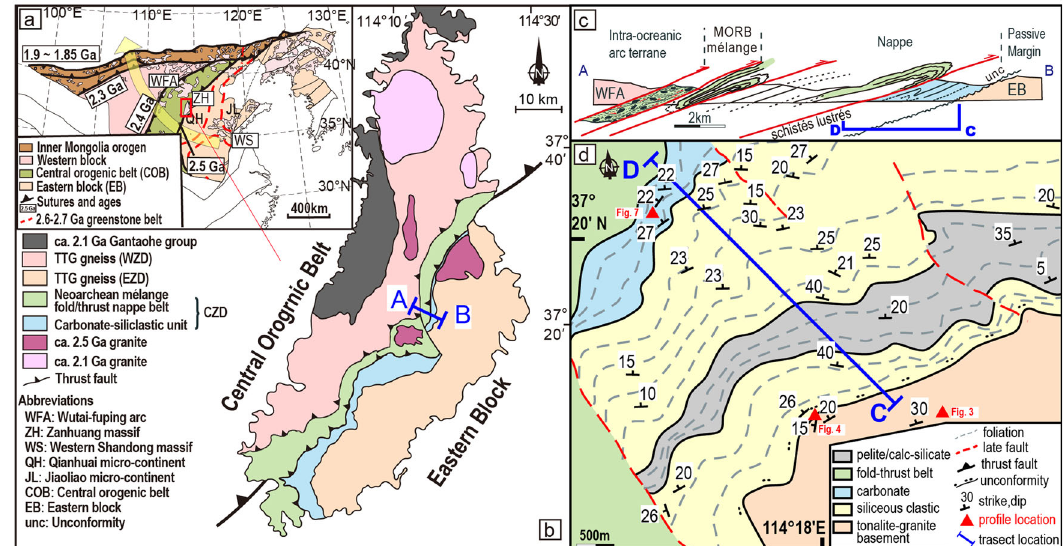
Fig. 1 | Geological maps of study area. a Map of North China Craton (after 8 ) showing progressive growth by collisional tectonics. See text for explanation. The Zanhuang Complex is shown in red box. b Geological map of the Zanhuang Complex(after 16,25,30 ),locationmarkedin a .Seetextforgeologicalsetting.Blueline marks the location of the pro fi le section (Section A – C) with details shown in c .